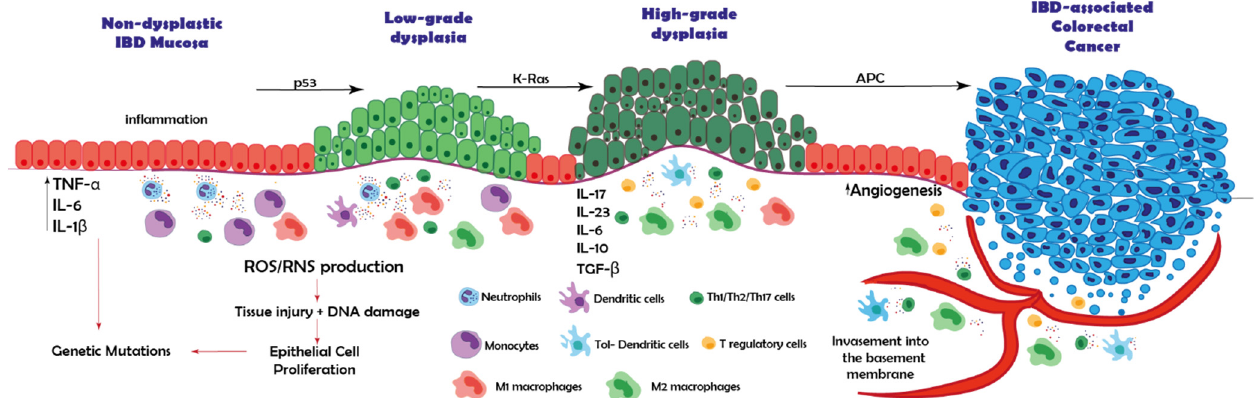
Figure 1. Schematic representation of the contribution of the immune system in the dysplasia to carcinoma sequence in IBD-associated cancer. Chronic inflammation promotes the recruitment of immune cells into the intestinal mucosa of inflammatory bowel disease (IBD) patients. These cells will secrete pro-inflammatory cytokines such as tumor necrosis factor alpha (TNF- α ), interleukin (IL) -6 and IL-1 β . In addition, these tissue-infiltrating cells produce oxidative compounds including reactive oxygen species and reactive nitrogen species, generating tissue injury and DNA damage, promoting excessive epithelial cell proliferation and favoring genomic aberrations and genetic mutations. TP53 mutations result in low-grade dysplastic mucosa, after which mutations in KRAS are considered to be involved in progression from low-grade dysplasia to high-grade dysplasia. Finally, mutations in the APC gene result in cancer. Chronic inflammation also induces immunosuppressive mechanisms that may be involved in cancer progression, such as recruitment of M2 macrophages, T regulatory cells (Tregs) or T lymphocytes expressing inhibitory markers; programmed cell death protein 1 (PD-1), cytotoxic T-lymphocyte-associated protein 4 (CTLA-4). In addition, there is an increase in angiogenic factors and anti-inflammatory cytokines; IL-10 and transforming growth factor beta (TGF- β ) which favor carcinoma development. (Tol-Dendritic cells: Tolerogenic dendritic cells, ROS: reactive oxygen species, RNS: reactive nitrogen species).